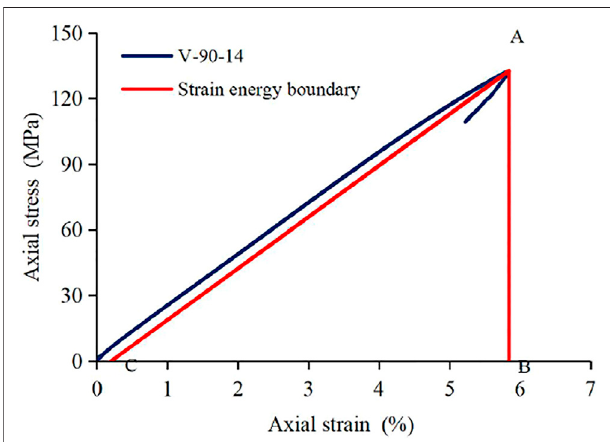
FIGURE11| Relationshipbetweenelasticenergyanddissipatedenergy in stress – strain